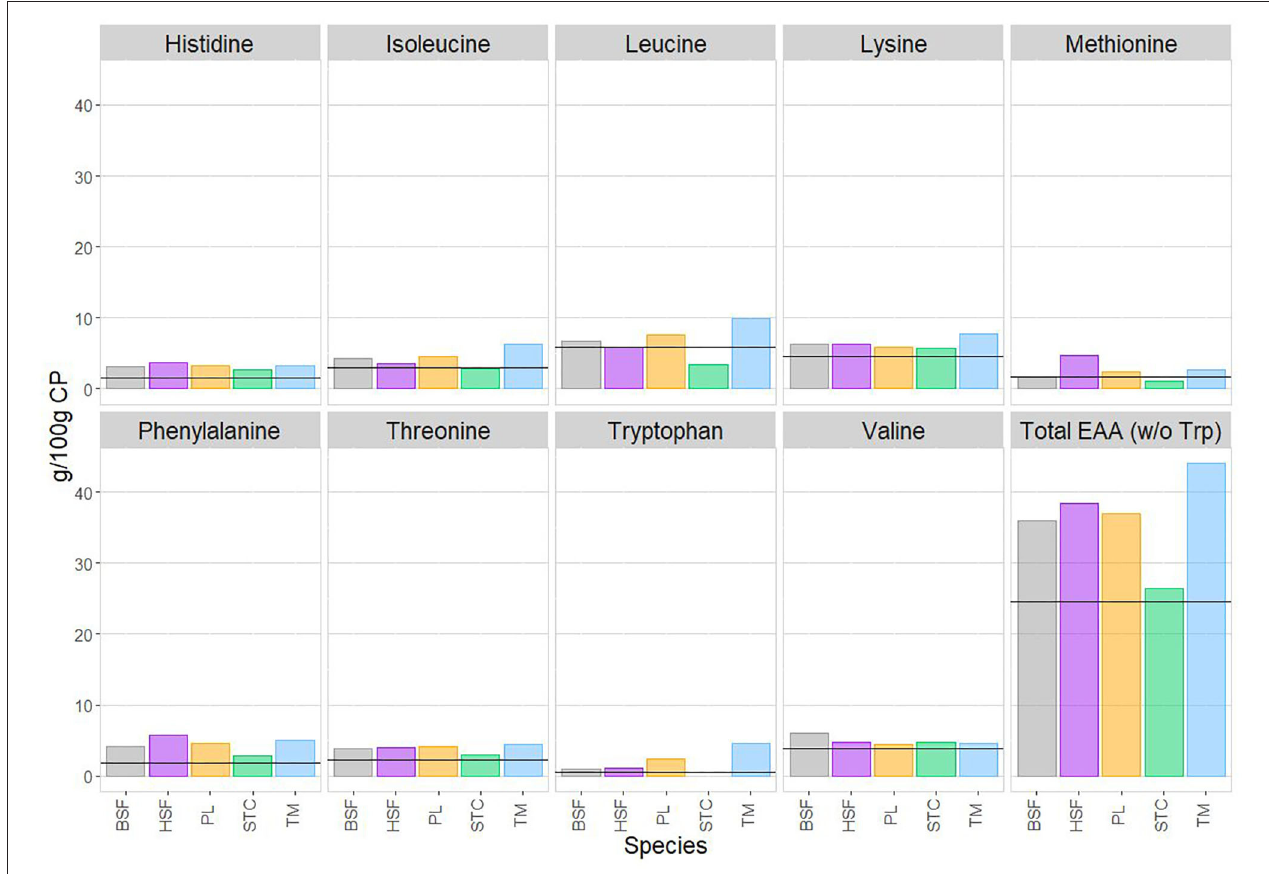
FIGURE 4 | The mean content of each essential amino acid, in g/100g of crude protein, in each species of edible insect, alongside the total sum of essential amino acids. As neither of the two published papers on C. butyrospermi’s amino acid content reported tryptophan, the mean total essential amino acid contents have here been calculated in the absence of tryptophan. The horizontal lines superimposed onto each panel refer to current estimates for adult requirements of each amino acid, obtained from WHO/FAO/UNU (75). Within each amino acid panel, reported is, from left to right: Hermetia illucens (black soldier fly, BSF; in gray), Musca domestica (house fly, HSF; in purple), Rhynchophorus phoenicis (palm weevil, PL; in orange), Cirina butyrospermi (shea tree caterpillar, STC; in green), and Macrotermes bellicosus (termite, TM; in